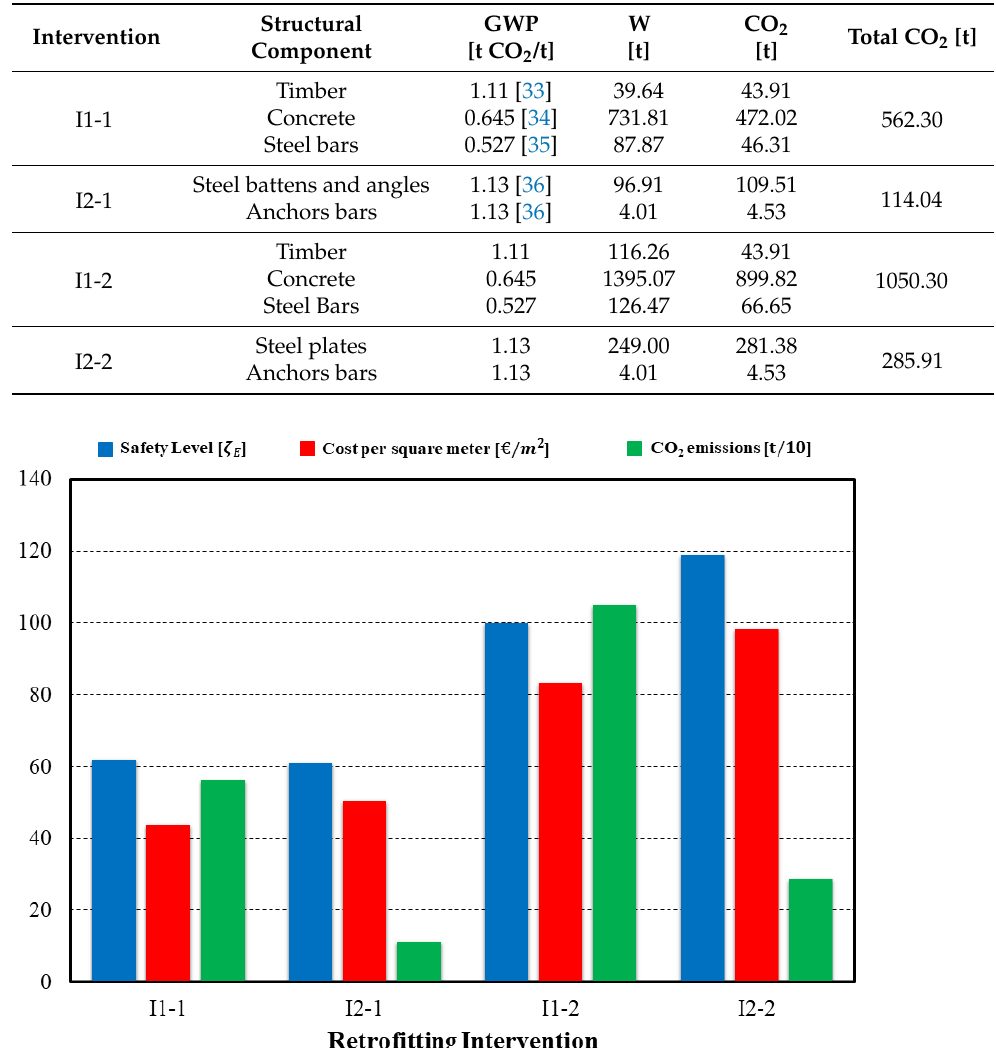
Figure 17. Summary of the comparison of the proposed